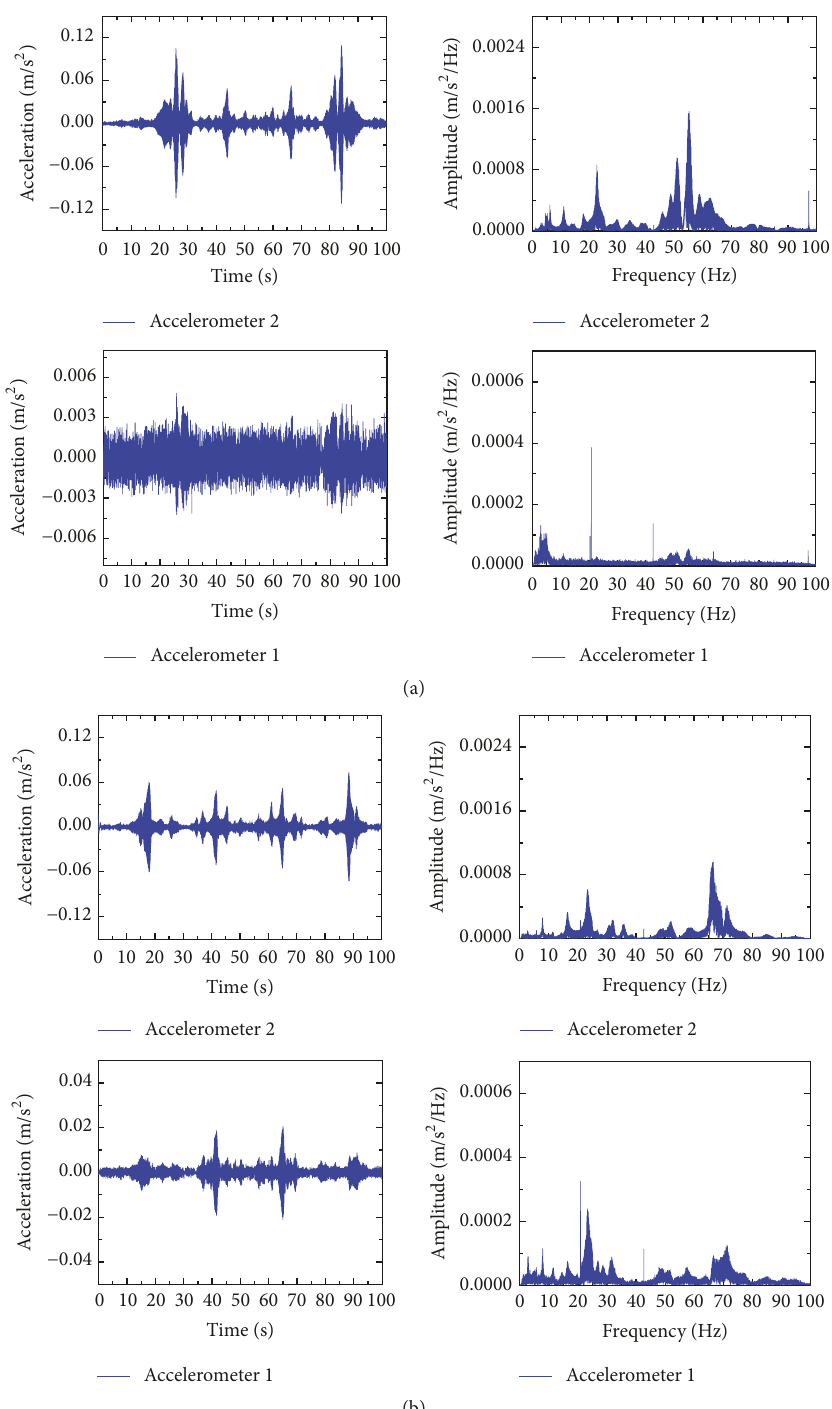
Figure 17: Vertical acceleration time histories and Fourier spectra: (a) novel antivibration bearing and (b) steel bearing.